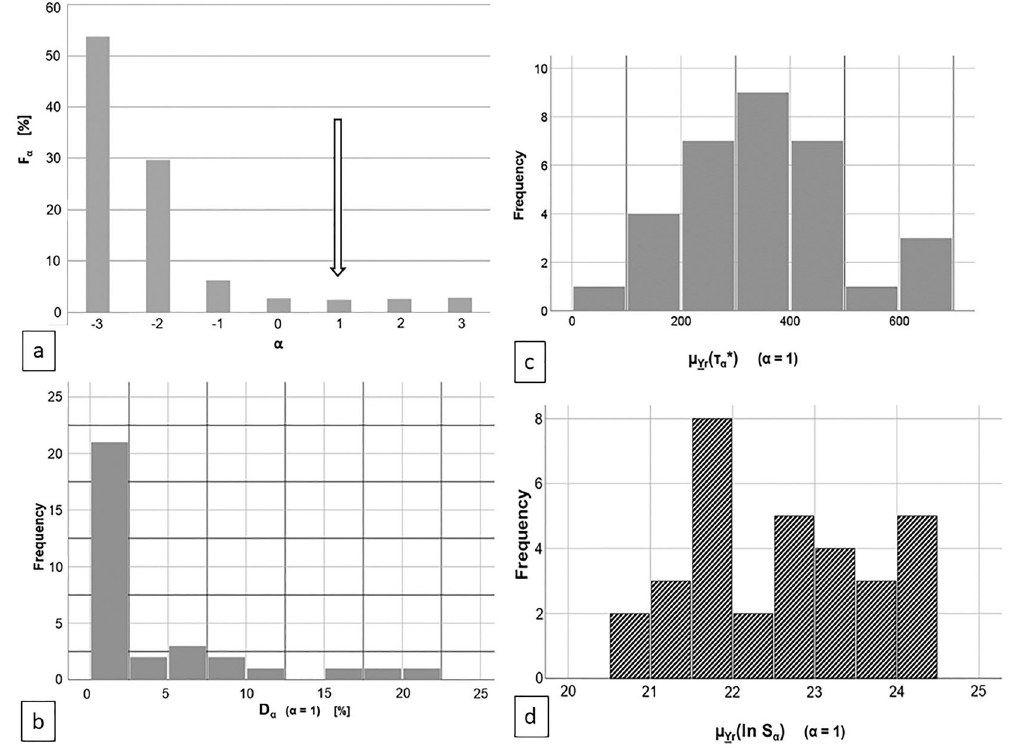
Figure 1. ( a ) Mean FM misclassification rate F α for whole body CT sample Ψ as a function of weight exponent α. ( b ) Histogram of the FM misclassification rate D α for α = 1. ( c ) Histogram of μ Yr (τ* α ) with α = 1. ( d ) Histogram of μ Yr (ln S α ) for α =